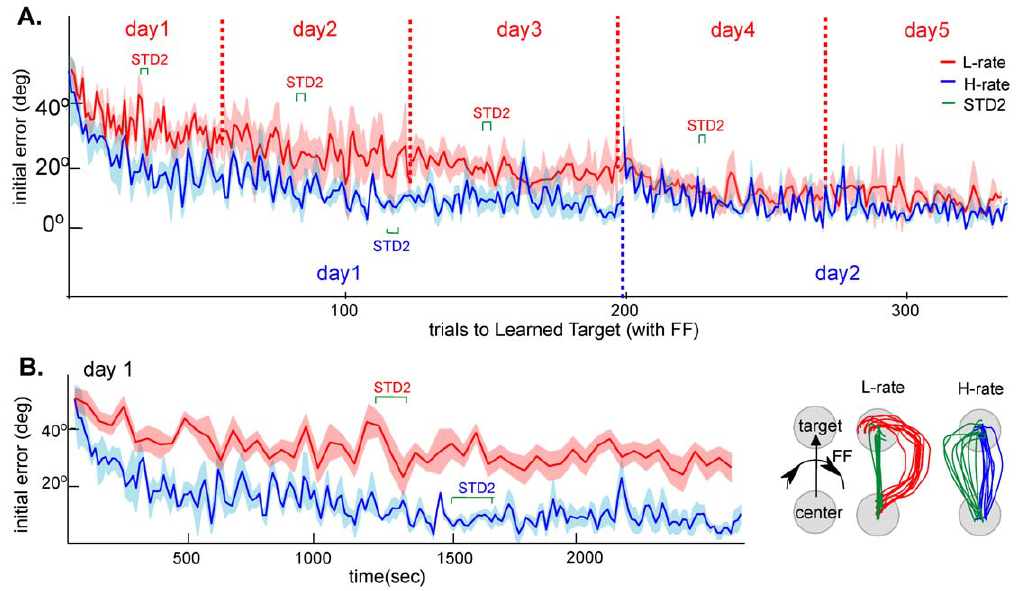
Figure 2. Movement kinematics show slow or fast improvement during L-rate and H-rate learning sets, respectively. (A) Initial directional deviation of movements to the learned target (LT), as a function of the number of trials to the learned target along the learning days of L- rate (red) and H-rate (blue). (B) Initial directional deviation as a function of time during the first day of the L-rate (red) and H-rate (blue) learning sets. Right: examples of trajectories to the learned target on the last 10 force-field trials (red, blue) and during the STD2 (green) on the first learning day. Note that performance under the H-rate showed complete adaptation on the first day with minimal deviation under the perturbation and large aftereffects in the standard trials that followed adaptation. In contrast, under the L-rate condition it took 4-5 days to reach similar performance. Green brackets denote the range in which the STD2 epoch interfered with learning at different learning sets (standard trials are not shown). Shaded areas denote SEM.